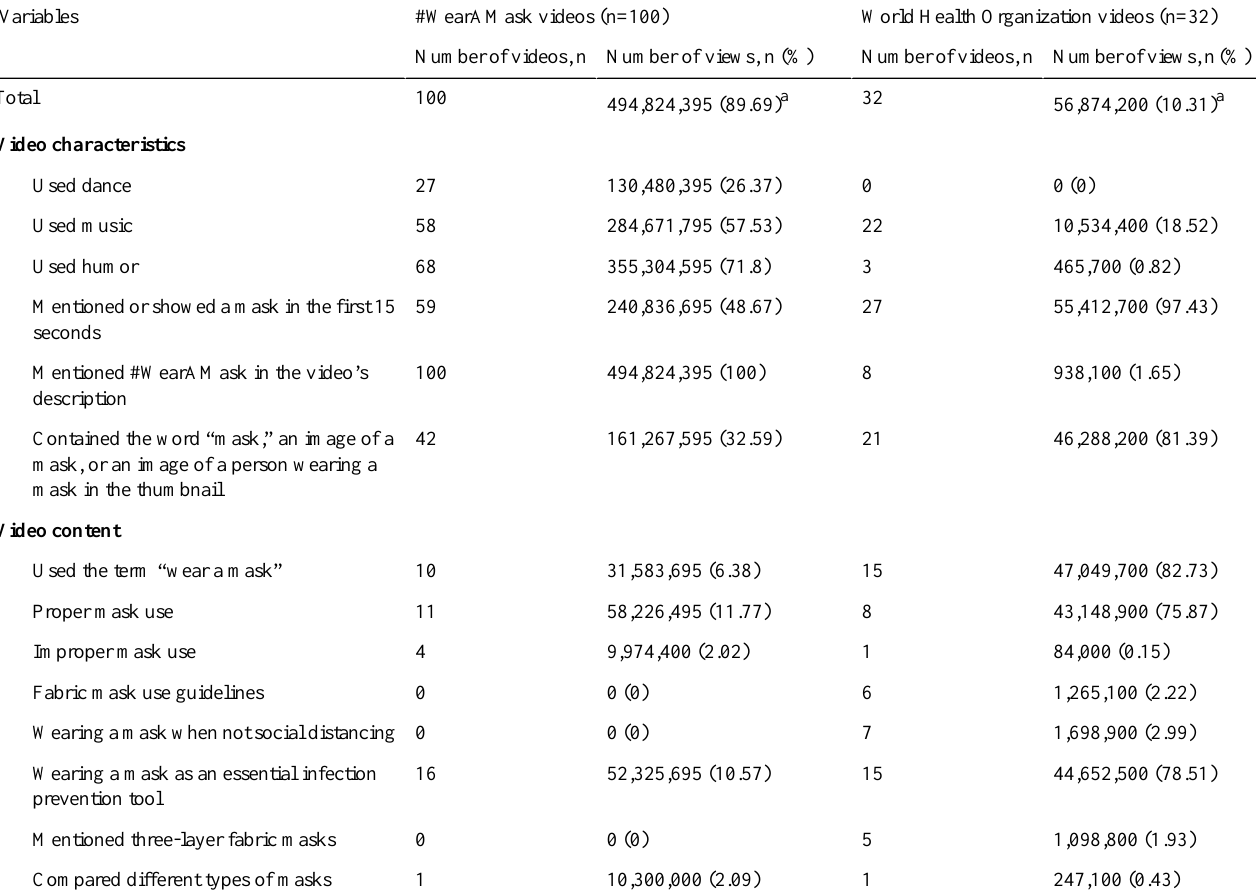
Table 1. Observed characteristics, content, and view count of 132 TikTok videos (ie, 100 videos with the #WearAMask hashtag and 32 videos created by the World Health